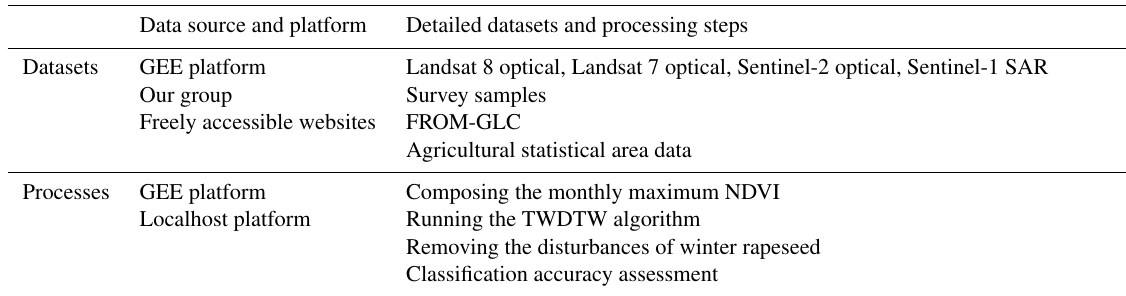
Figure 9. Comparison between the estimated planting area of winter wheat and agricultural statistical area at the municipal (I) and county level (II) for 2018. The dotted line denotes the 1 : 1 line. The agricultural statistical area at the county level for AH and SAX are not available. The units of RMSE and MAE are 1000ha. Table 3. The detailed information of the datasets and processes in this